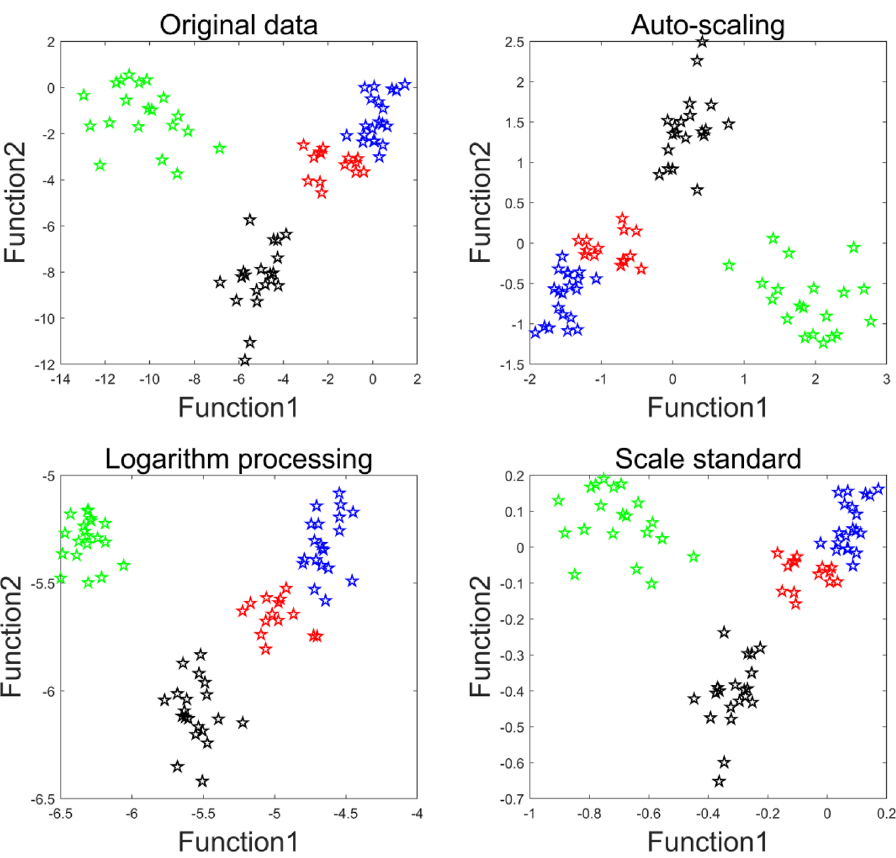
Figure 3. The classification of 95 LHG samples by LDA based on different data pre-processing methods (blue: Guangxi; black: Hunan; green: Guizhou; red: Jiangxi).